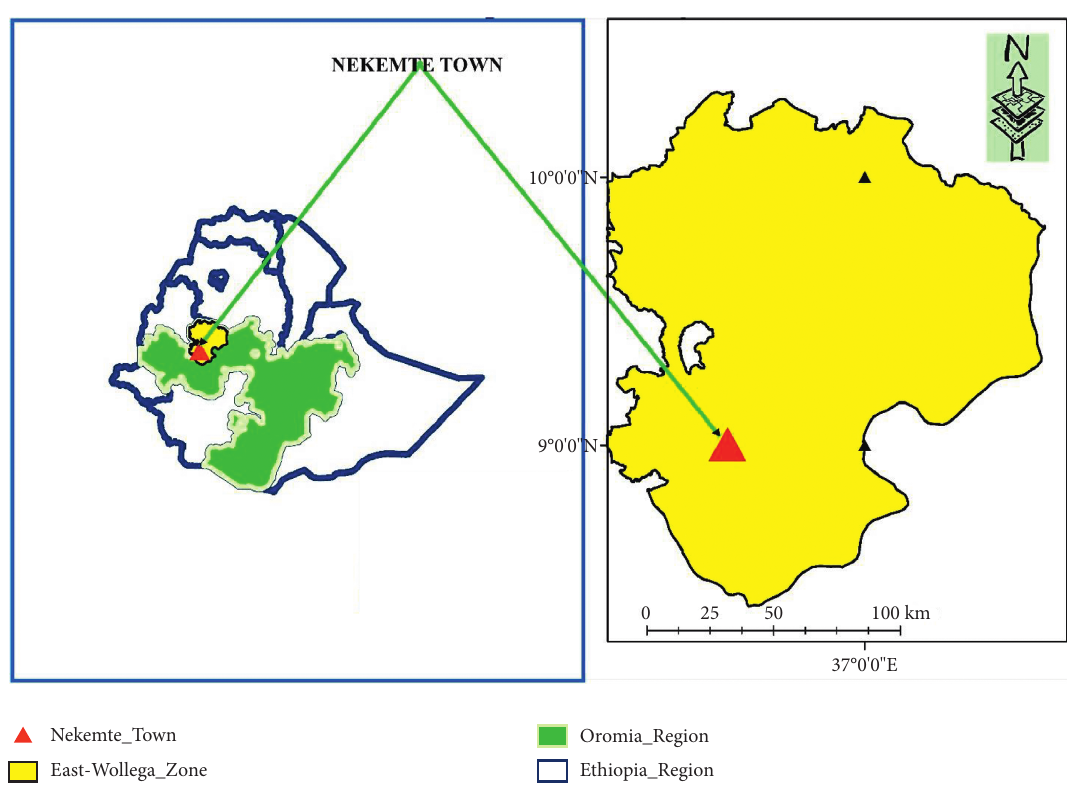
Figure 1: Map of the study area, Nekemte town, East Wollega zone,